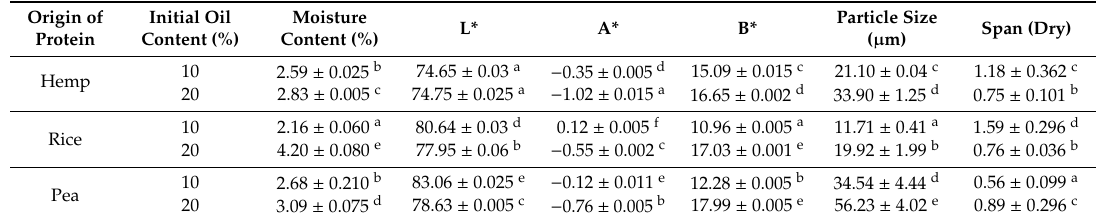
Table 2. Physical properties of hempseed oil microcapsules encapsulated with combination of proteins with